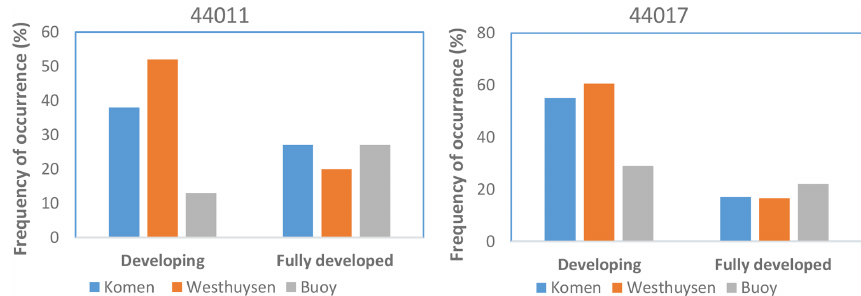
Figure 14. Frequency of occurrence for “developing” and “fully developed” sea states (based on Volov, 1970, and Oost, 1998) at stations 44011 and 44017 from buoy data and simulations using Komen and Westhuysen whitecapping